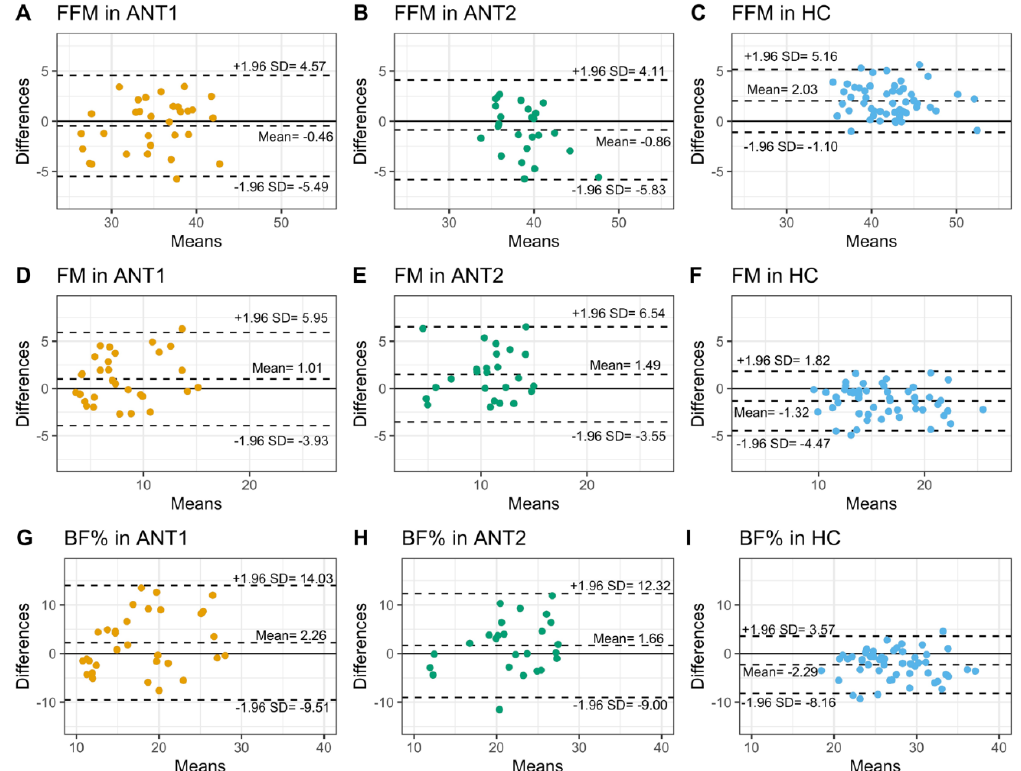
Figure 2. Bland-Altman agreement between DXA and BIA estimates of body composition. The agreement between DXA and BIA derived body compositions was assessed using Bland-Altman analysis. Mean bias and limits of agreement are shown as dotted lines in ANT1 (orange), ANT2 (green), and HC (blue), for FFM ( A – C ), FM ( D – F ), and BF% ( G – I ). FFM: Fat-free mass, FM: Fat mass, BF%: Body fat percentage, DXA: Dual-energy X-ray absorptiometry, BIA: Bioelectrical impedance analysis.